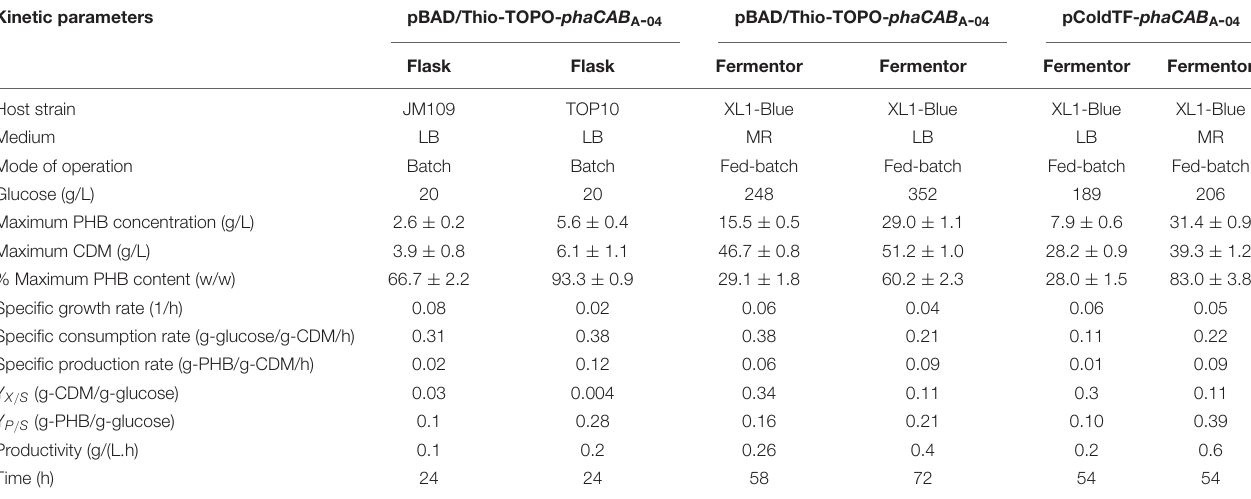
FIGURE 5 | Effect of inoculum size from 4.5 × 10 8 , 3.2 × 10 9 , and 1.5 × 10 10 CFU/mL on the specific growth rate and specific production rate (A) and transmission electron micrograph of ultrathin sections of pBAD/Thio-TOPO- phaCAB A - 04 expressing E. coli TOP10 grown in LB medium. (B) Typical short rod cells containing one PHB granule (white fractions). Bar 0.5 µ m. TABLE 2 | Comparison of kinetic parameters obtained from flask cultivation and fed-batch cultivation for PHB production from glucose between pBAD/Thio-TOPO-